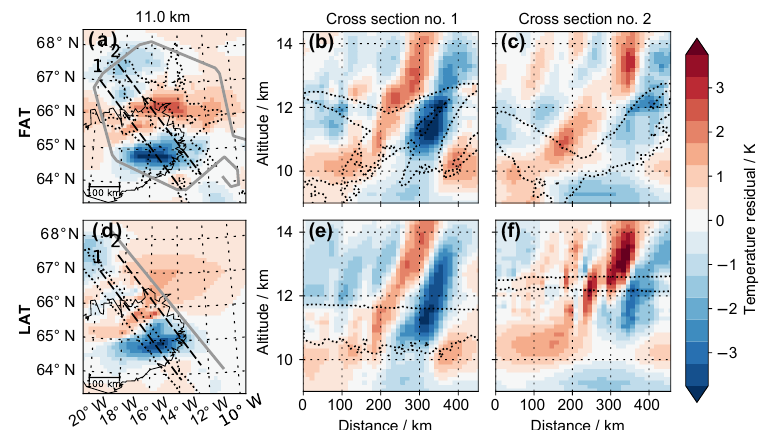
Figure 11. Comparison of FAT (a–c) and LAT (d–f) retrieval results for a research flight over Iceland on 25 January 2016. Shown are the temperature residuals after background removal as described in Sect. 2.5. The grey line indicates the part of the flight path from which the measurements are used for the retrieval. The left column depicts horizontal cross sections at 11km altitude; the two right columns present vertical cross sections along the dashed lines of the left column. The dotted lines mark the area covered by tangent points. Panels (a) to (c) are adapted from Krisch et al. (2017, Fig.